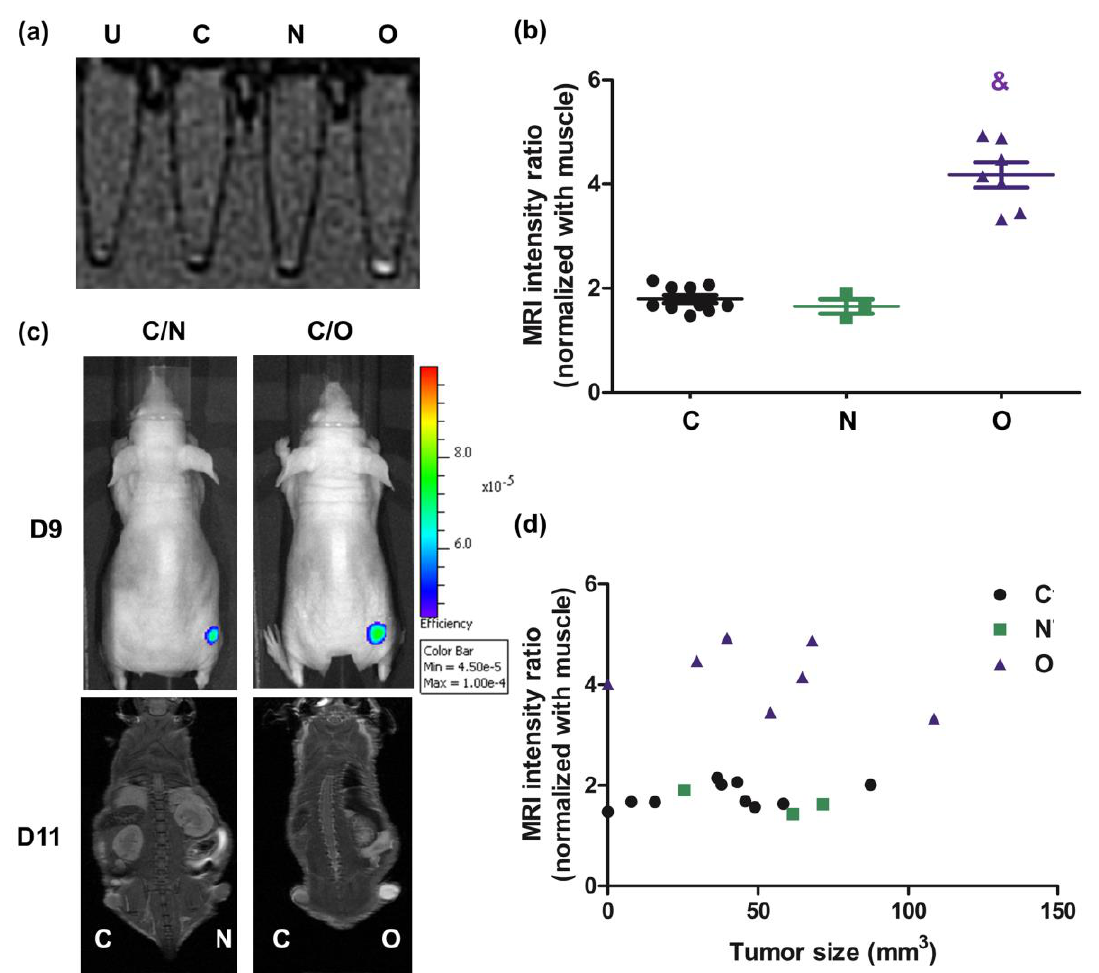
Figure 4. MRI contrast-Gd-EOB-DTPA intake in vivo in magnetic resonance imaging (MRI). ( a ) After HT-29 cells were transduced into NTCP and OAT1B3 independently, treated with Gd-EOB-DTPA (MRI contrast) for 4 h, and detected using 3T-MRI scanning. ( b ) The relative signal intensity of the control and NTCP - and OATP1B3 -expressing xenografts adjusted based on the signal intensity of muscles in MR images. Error bars indicate the SEM. N = 8, N = 3, and N = 5 in control, NTCP -expressing tumor cells, and OATP1B3-expressing tumor cells, respectively. ( c ) ICG intensity was acquired using IVIS 9 d after xenograft. MRI intensity was detected using 7T-MRI approximately 1 h after injecting MRI contrast into NTCP - and OATP1B3 -expressing tumor-bearing mice 11 d after xenografting. The tumor on the left hind leg was the control tumor, and on the right was the NTCP -expressing tumor (at the top) and the OATP1B3 -expressing tumor (at the bottom). ( d ) The relationship between tumor size and MRI signal at 1 h after ICG injection into NTCP - and OATP1B3 -expressing tumor-bearing mice. C: control HT-29 cells or tumor. N: NTCP -expressing HT-29 cells or tumor. O: OATP1B3 -expressing HT-29 cells or tumor. & p < 0.001.